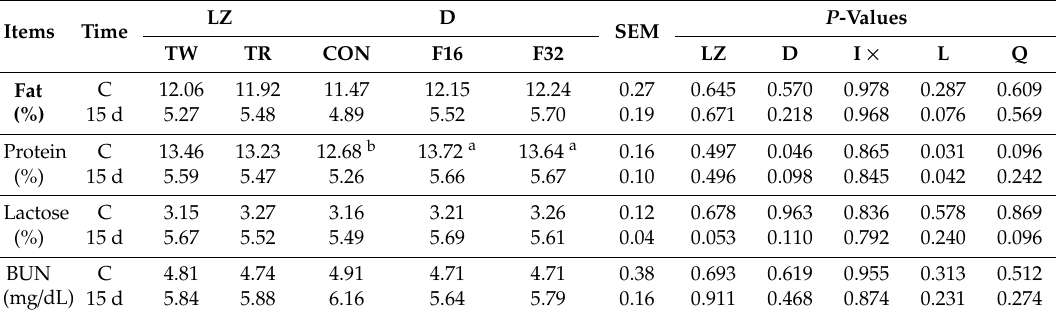
Table 7. Components of colostrum and normal